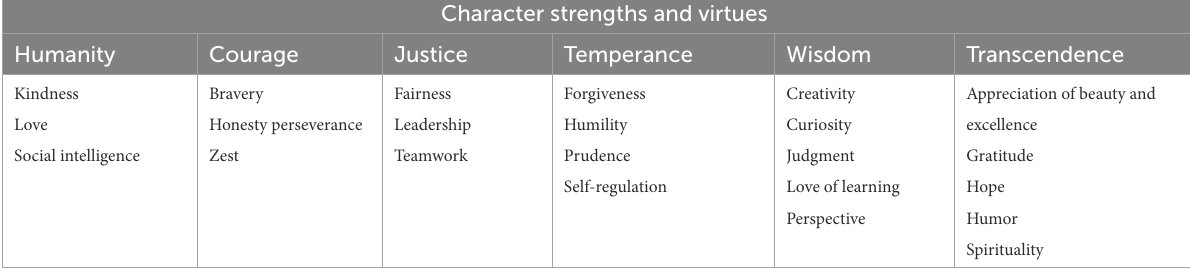
Character strengths and virtues